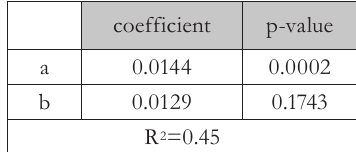
Tab. 3 – OLS estimation of beta-convergence equation for 35 Visegrad Group countries NUTS-2 regions. Source: Author’s own